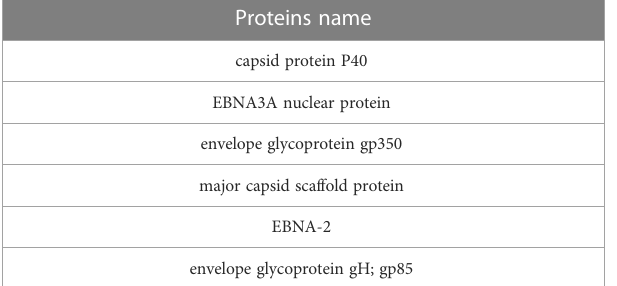
TABLE 6 Selected non-toxin proteins in both strains.